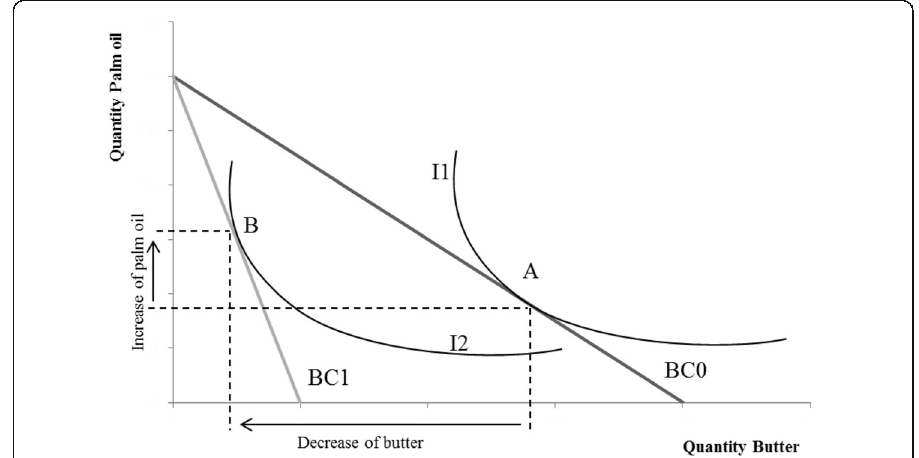
Fig. 8 Effect of a butter price increase on palm oil. Source: Adapted from Frank